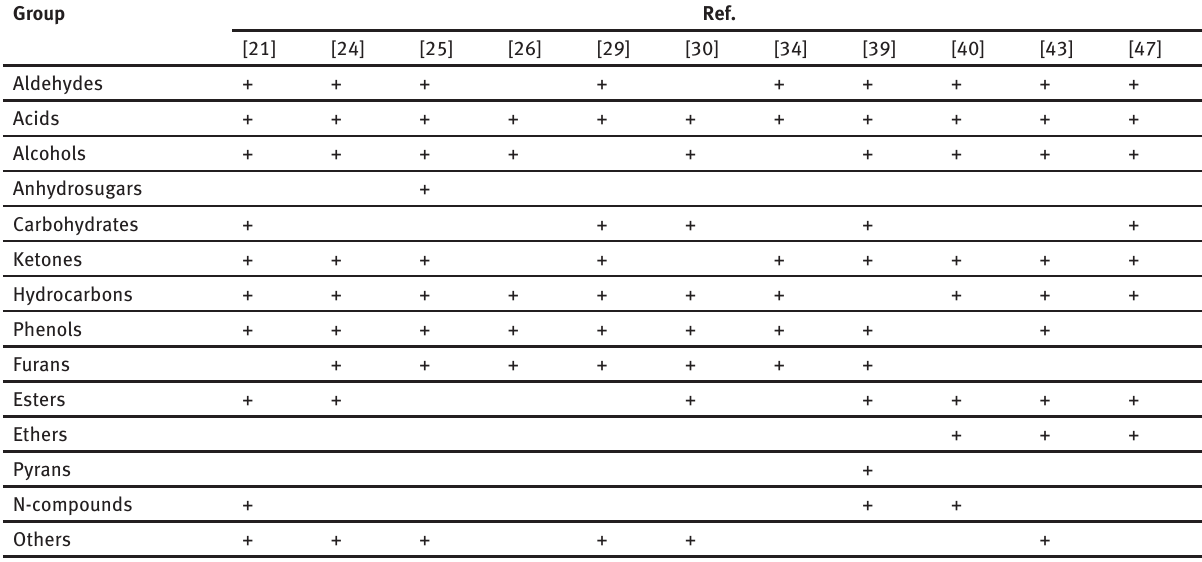
Table 2 The most popular groups of products formed in fast pyrolysis of lignocellulosic biomass identified on the basis of Py-GC/MS experiments Group